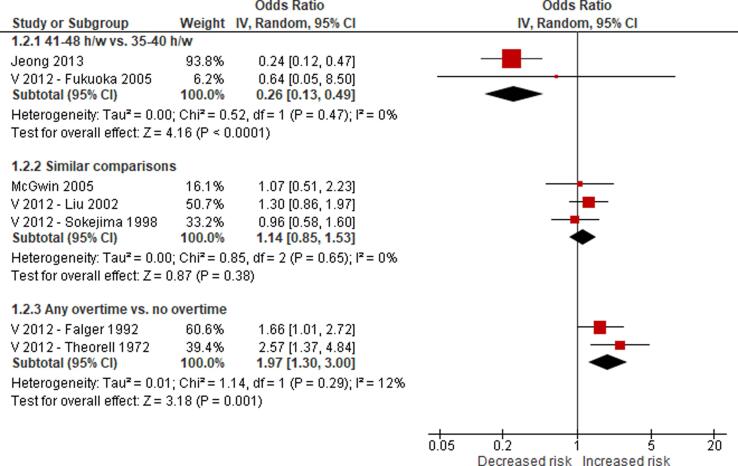
Supporting meta-analysis of deprioritized evidence (case-control studies), Outcome: Acquired ischaemic heart disease, Comparison: Worked 41–48 h/week compared with worked 35–40 h/week (or similar comparisons, or any overtime work). Footnotes: The similar comparisons included in this meta-analysis were: McGwin 2005: 41-50 h/w vs. <40 h/w; Virtanen 2012 - Liu and Tanaka, 2002: 41 to 60 h/w vs. ≤40 h/w; and Virtanen 2012 - Sokejima 1998: 9.01 to 11.00 h/d vs. 7.01 to 9.00 h/d.